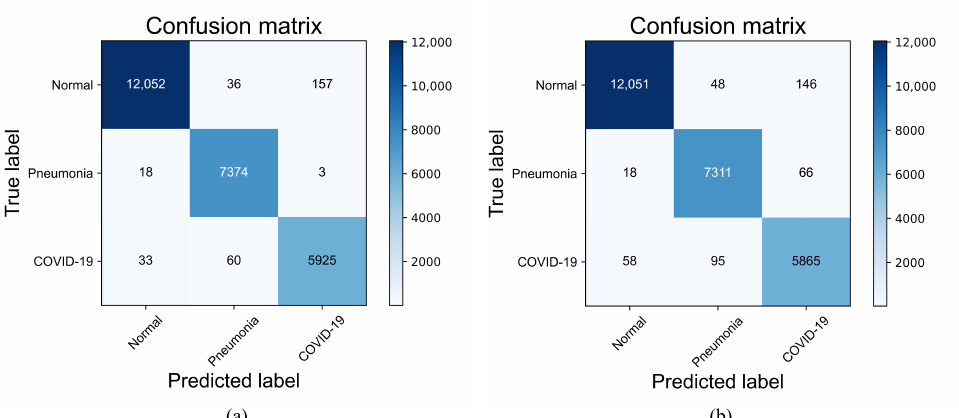
Figure 8. Confusion matrixes of two models tested on the COVIDx CT-2A dataset. ( a ) represents the improved VGG19; ( b ) represents the original VGG19.